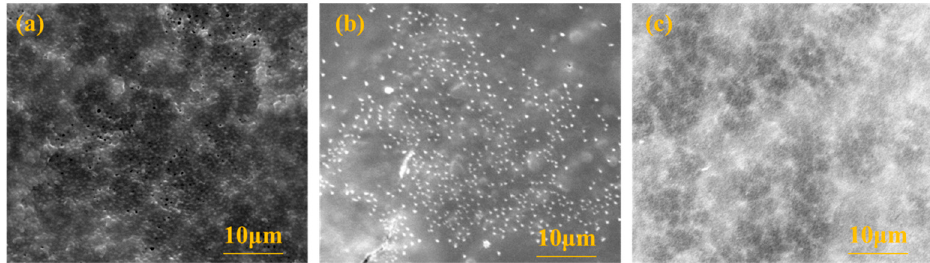
Figure 5. The surface observation of the microfiltration membrane by SEM instrument: ( a ) the new membrane; ( b ) after blocking; ( c ) after flushing with deionized water .